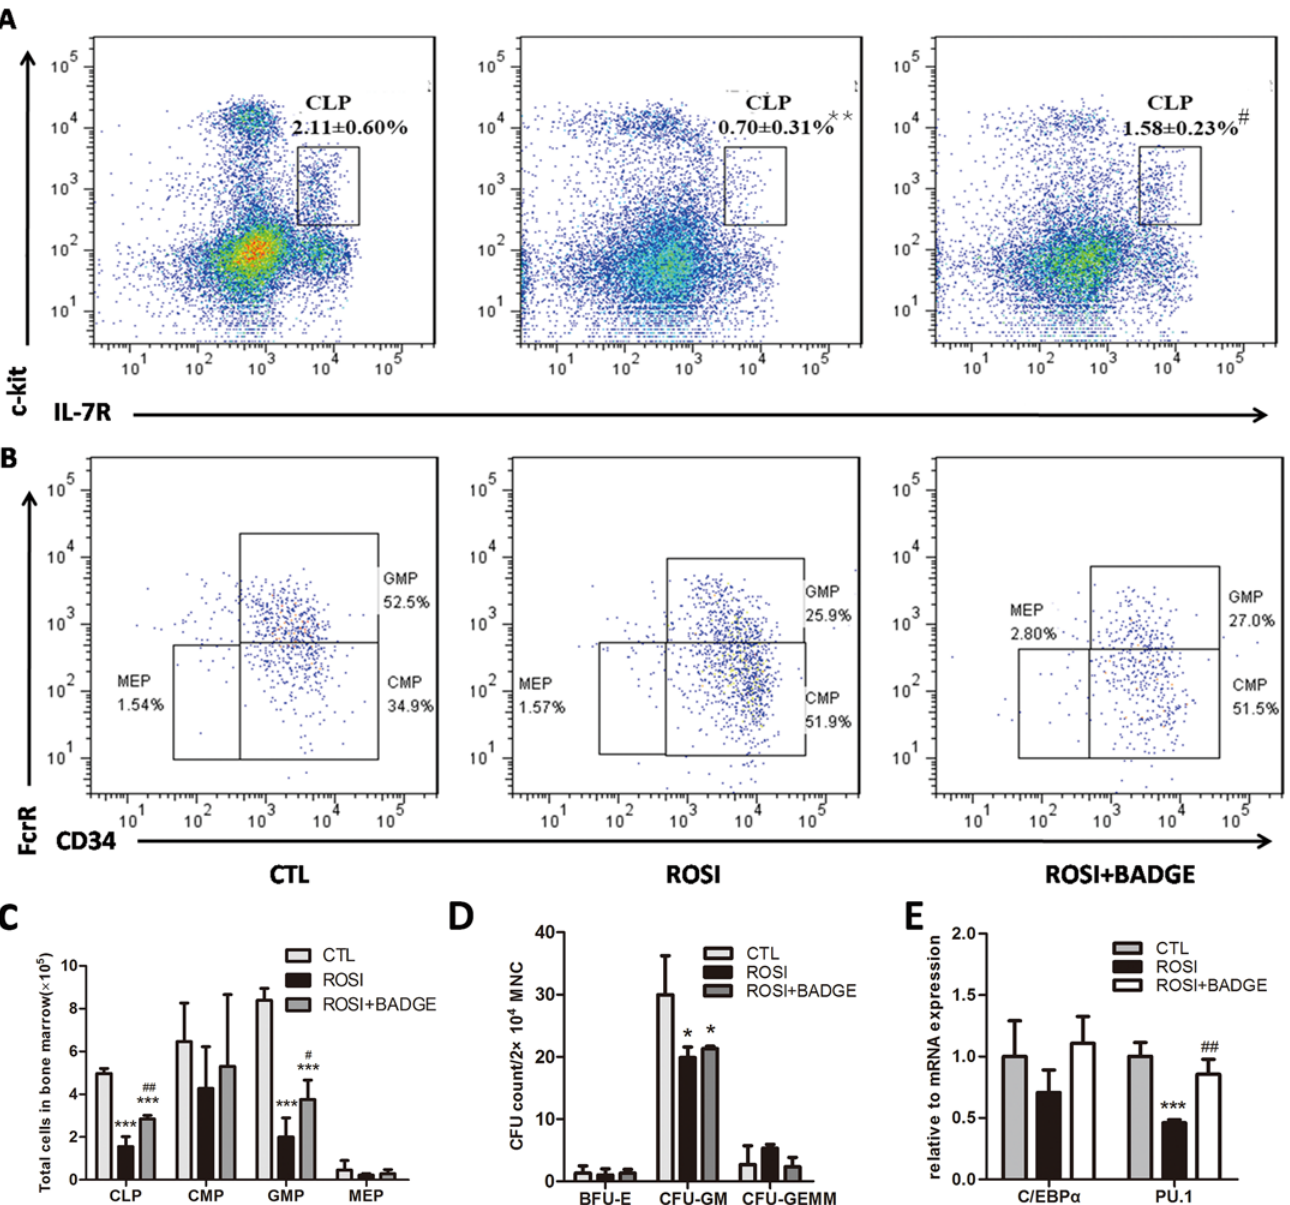
Fig 4. Rosiglitazone impairs differentiation of myeloid progenitors in vivo . (A-C) Flow cytometric analyses of HPC subsets in the BM 14 days after 5-Fu. (D) The colony-forming potential of BMMNCs 14 days after 5-Fu treatment. (E) RNA was extracted from BMMNCs from the CTL, ROSI and ROSI+BADGE group, and samples were analyzed for the expression of C/EBP α and PU.1. The data are presented as the means ± SD of three independent experiments, * P < 0.05 compared to CTL, ** P < 0.01 compared to CTL, # P < 0.05compared to ROSI, ## P < 0.01 compared to